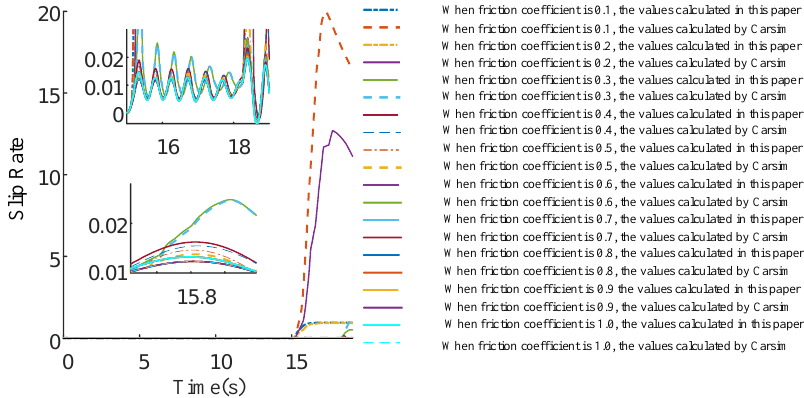
Table 1. Vehicle parameters.